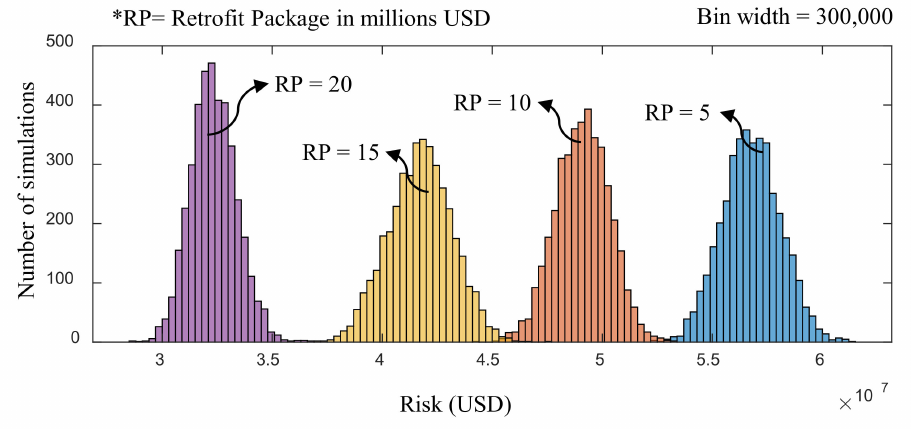
Figure 12. Mean values of buildings at different retrofit levels in a population along with considered four retrofit programs.